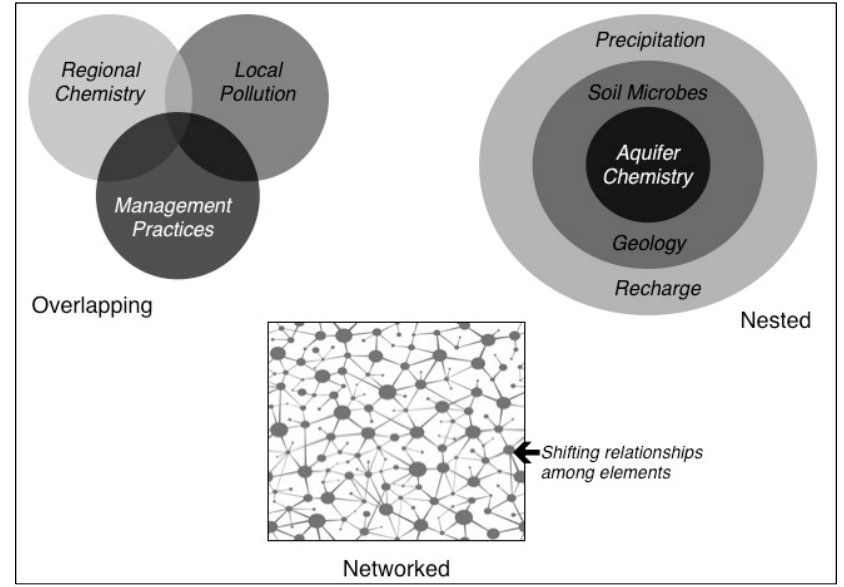
Figure 2. Schematic representations for three pattern relationships described in this